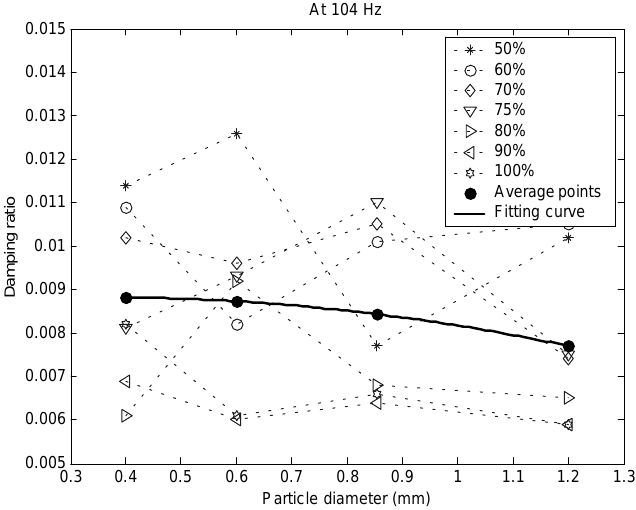
Fig. 10. Damping ratio vs. particle diameter for different packing ratios at 104 Hz.